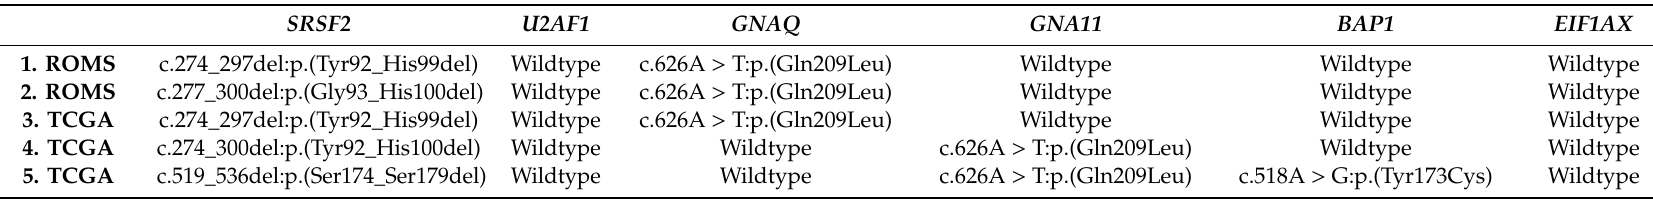
Table 2. Overview of mutations in uveal melanoma samples with an SRSF2 or U2AF1 mutation. ROMS = Rotterdam Ocular Melanoma Studygroup; TCGA = The Cancer Genome